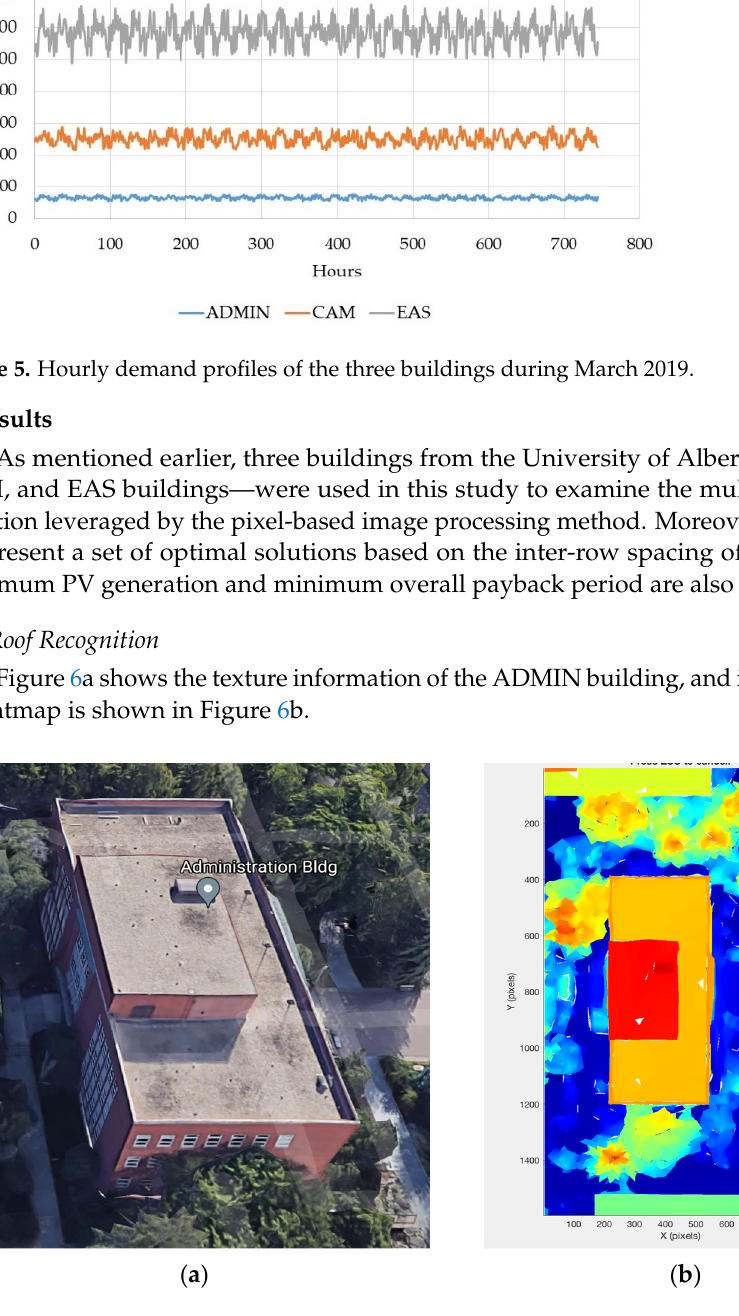
Figure 5. Hourly demand profiles of the three buildings during March 2019.